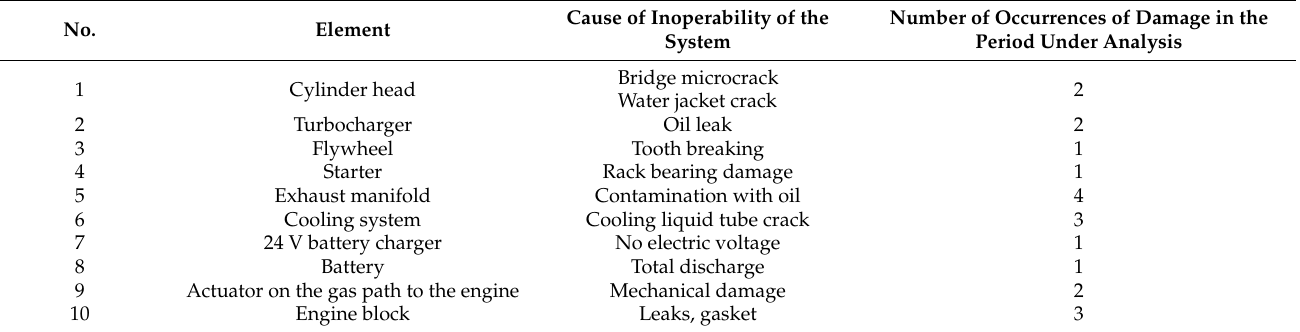
Table 6. Type and cause of failures of the CHP